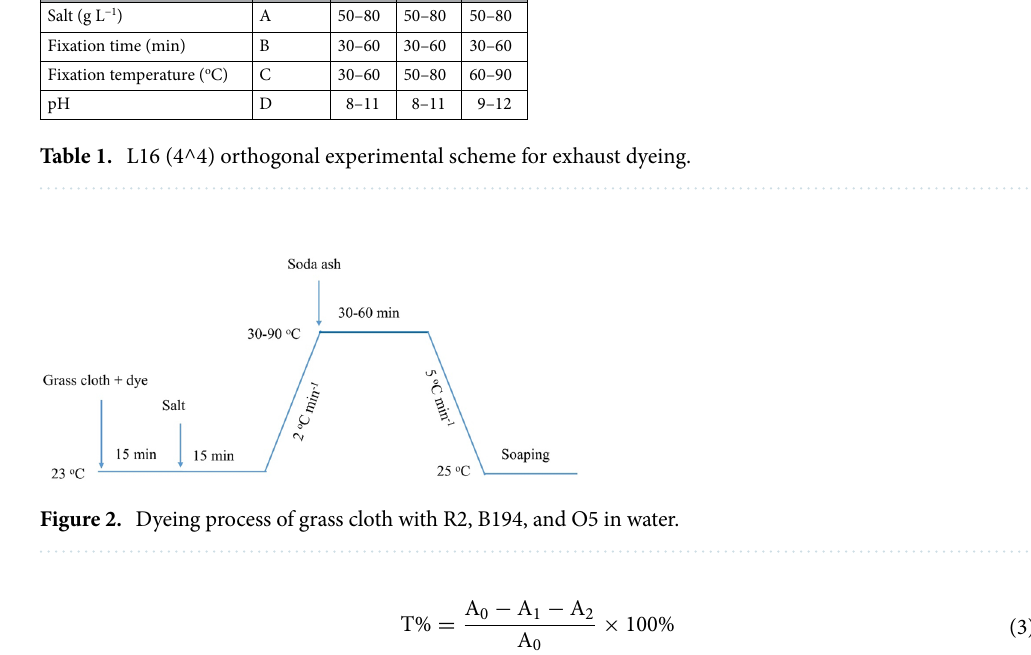
To determine the color coordinates of the dyed sample, CIElab color space L*, a*, and b* values, as well as the color strength (K/S) values, were measured at 20 random places using a CHN-Spec CS-650A spectrophotometer (Hangzhou Color Spectrum Technology Company, China). FTIR analysis of grass cloth was carried out using a Nicolet iS5 FT-IR spectroscopy (Thermo Fisher Scientific, USA). The morphology of the raw ramie yarn of grass cloth was investigated with a Phillips SEM scanning electron microscopy (FE-SEM, Germany). The color- fastness towards washing and rubbing of the fabric was tested in accordance with ISO 105-C06:2010 and ISO 105-X12:2016 standards, respectively 30 . Using a multi-fiber strip, colorfastness to washing was determined by measuring neighboring cotton fiber staining and comparing the results to the ISO standard grayscale 31 .